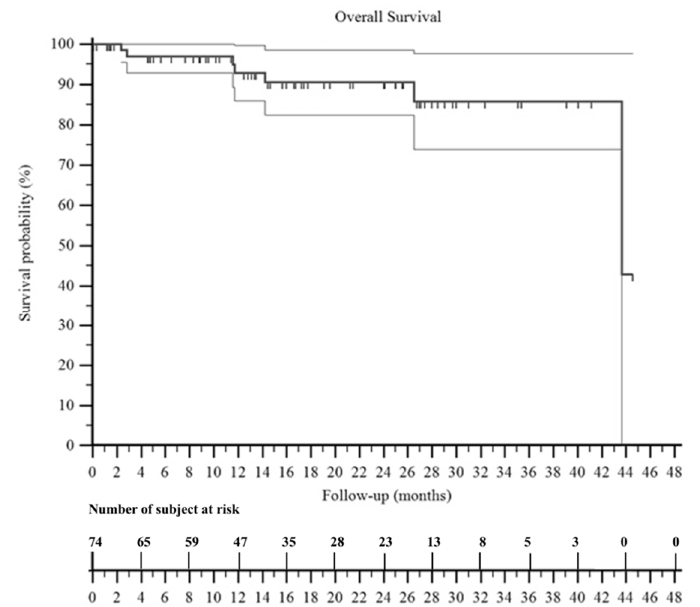
Figure 3. A Kaplan–Meier curve shows the overall survival of the patients included in this series. It was 92% at 2 years and 85% at 3 years. The two surrounding thin black lines represent the 95% confidence intervals.